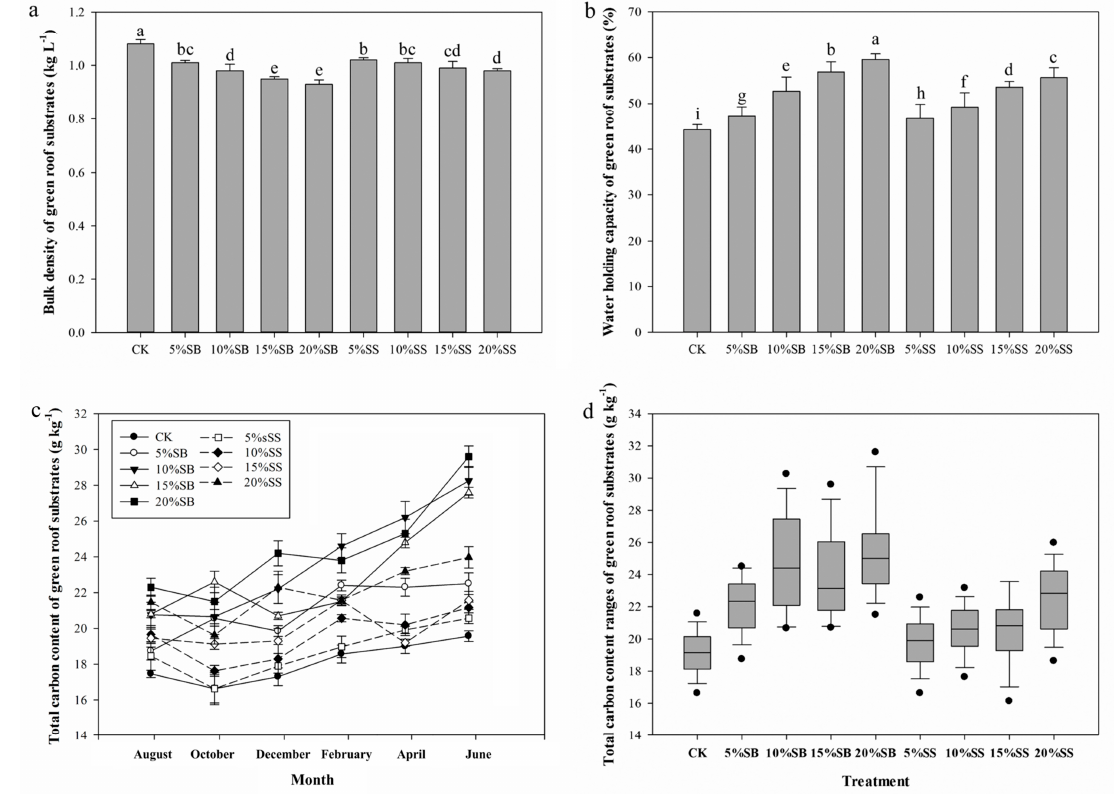
Figure 2. The properties and carbon content of green roof soil. ( a ) Bulk density of different green roof soils. ( b ) Water holding capacity of different green roof soils. ( c ) Total carbon (TC) content of different green roof soils in different months. ( d ) TC content ranges for different green roof soils for the 12 months of the experiment. The different letters indicate significant differences ( p -value < 0.05).